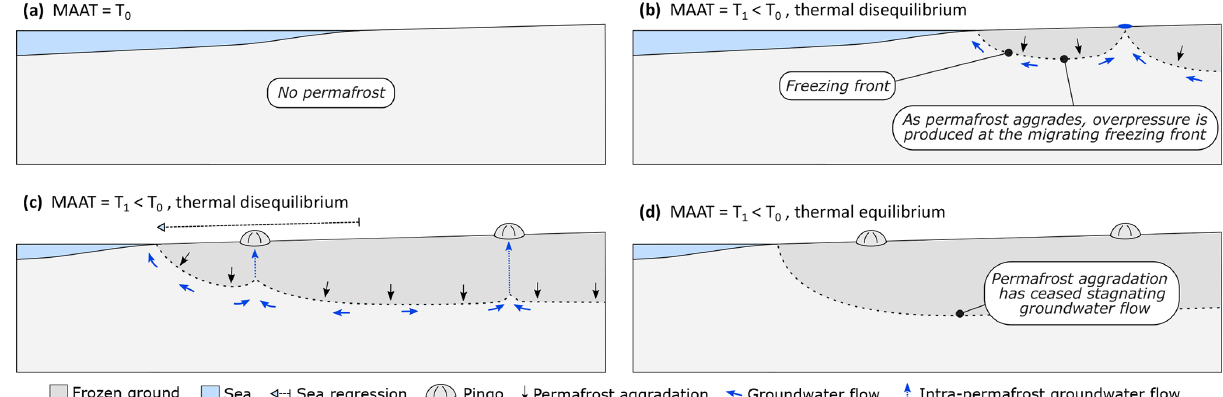
Figure 1. Conceptual model of pingo formation driven by permafrost aggradation in a low-permeability system. (a) No permafrost is present. (b, c) A negative shift in the surface energy balance results in permafrost aggradation. Freezing pressure is induced at the freezing front, and this results in hydraulic head gradients. At some distance inland, higher advective heat transfer, associated with higher groundwater velocities, prevents the ground from freezing and groundwater flows to the surface where a pingo forms at the spring. (d) The ground is in thermal equilibrium with the MAAT, permafrost aggradation has stagnated, and groundwater flow to the pingos has